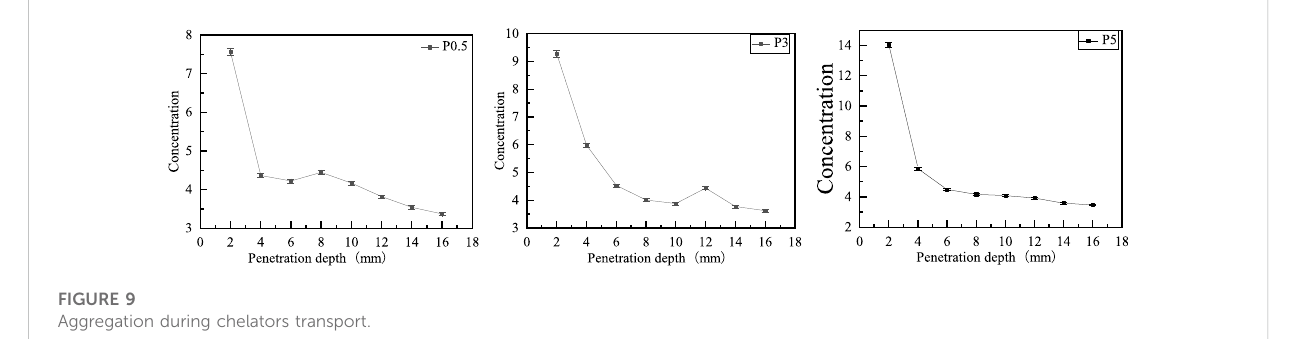
FIGURE 9 Aggregation during chelators